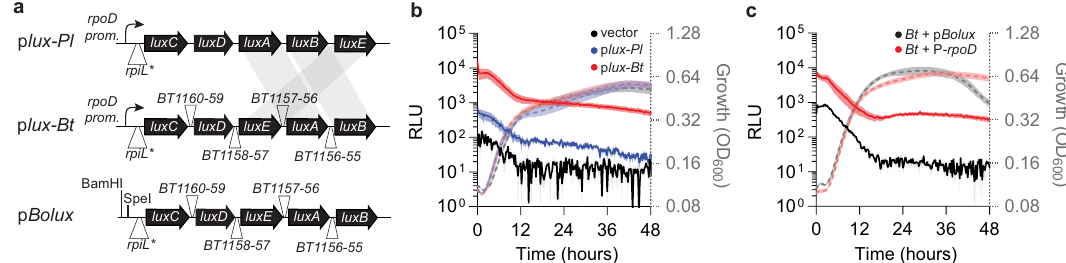
Fig. 2 | Construction of a Bacteroides-optimized bioluminescent reporter. a Schematic depicting the construction of a bioluminescent reporter thatencodes theentire Pllux cassetteundercontrolofthe BtrpoD promoterandrpiL*RBS(top); a Bacteroides-optimized lux cassette with rearranged luxA -E (indicated by the shaded regions) and Bt intergenic regions from a constitutively expressed Bt operon(BT1160-1155;middle);orp Bolux whichhasBamHIandSpeIsitespositioned upstream of the Bacteroides-optimized lux cassette (bottom) in the multi-copy plasmidpLYL01. b Relativeluminescence(solidlines)orgrowth(dashedlines)from Bt strains harboring an empty vector (black) or plasmids containing either the lux